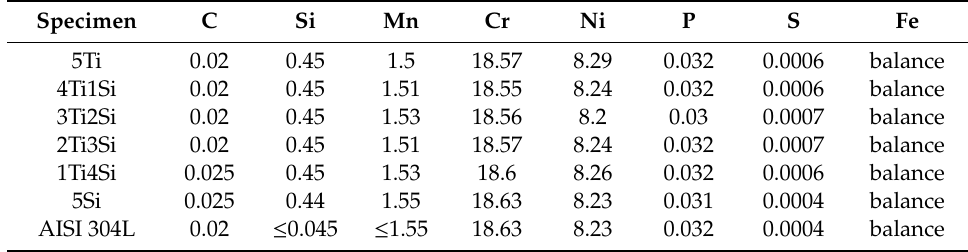
Table 4. Chemical compositions of the weld metals and 304L austenitic stainless steel in accordance with ASTM A240/A240M, wt.%.